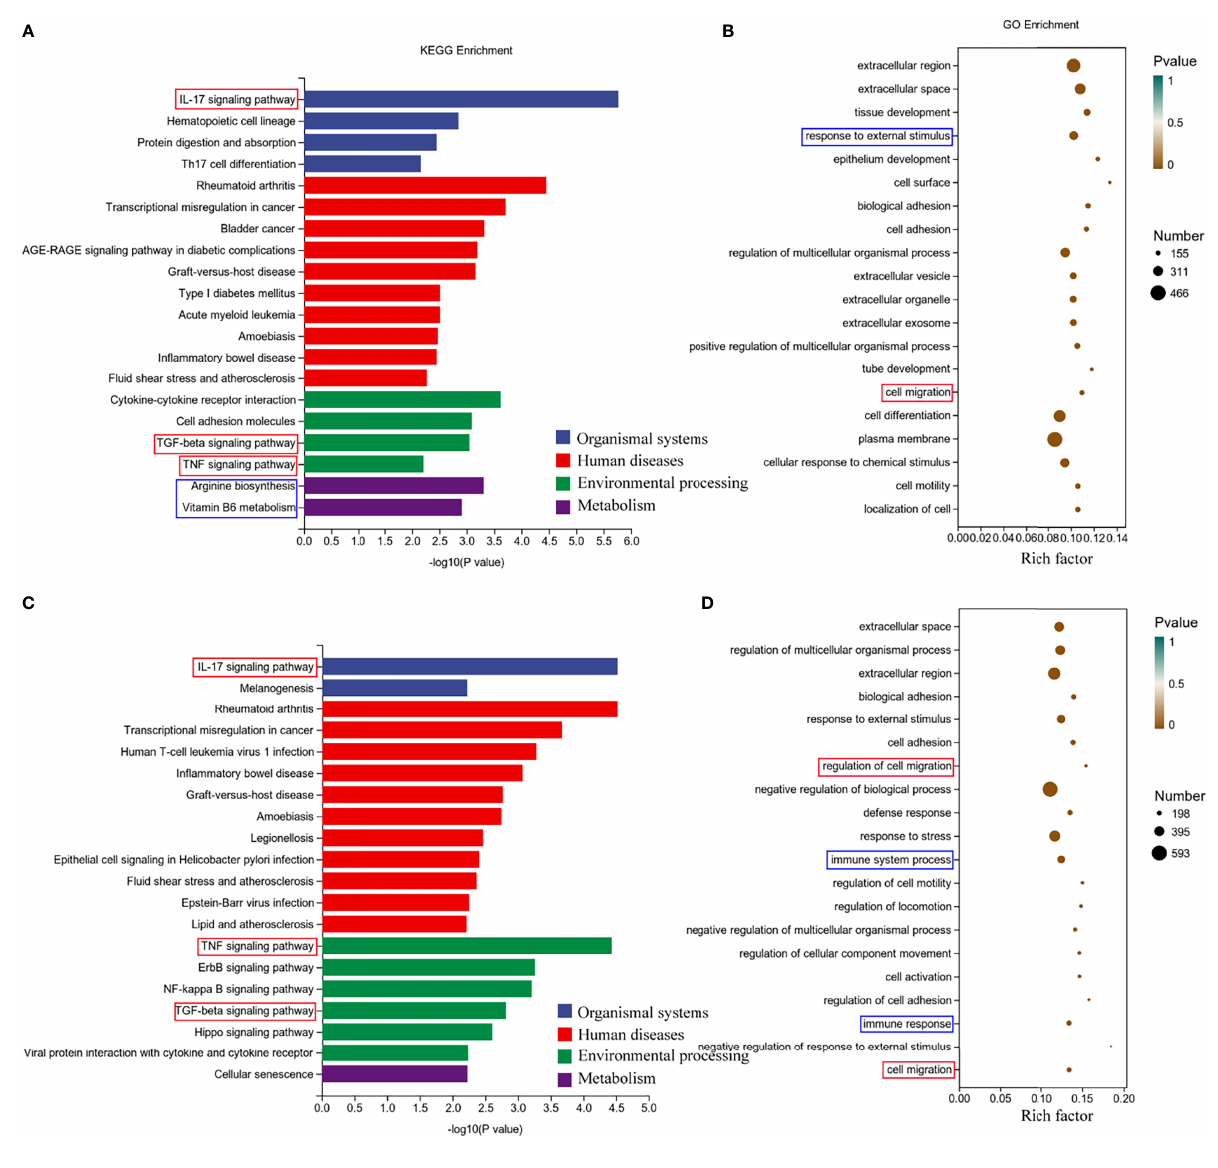
FIGURE 5 | Enrichment analysis of RNA-seq results of H1N1 virus-infected hNEC cells. (A, B) Kyoto Encyclopedia of Genes and Genomes (KEGG) pathway (A) and Genetic ntology (GO) (B) enrichment analysis of H1N1 virus-infected hNEC cells at 24h. (C, D) KEGG pathway (C) and GO (D) enrichment analysis of H1N1 virus-infected hNEC cells at 48h. The color of the bar indicates -log10